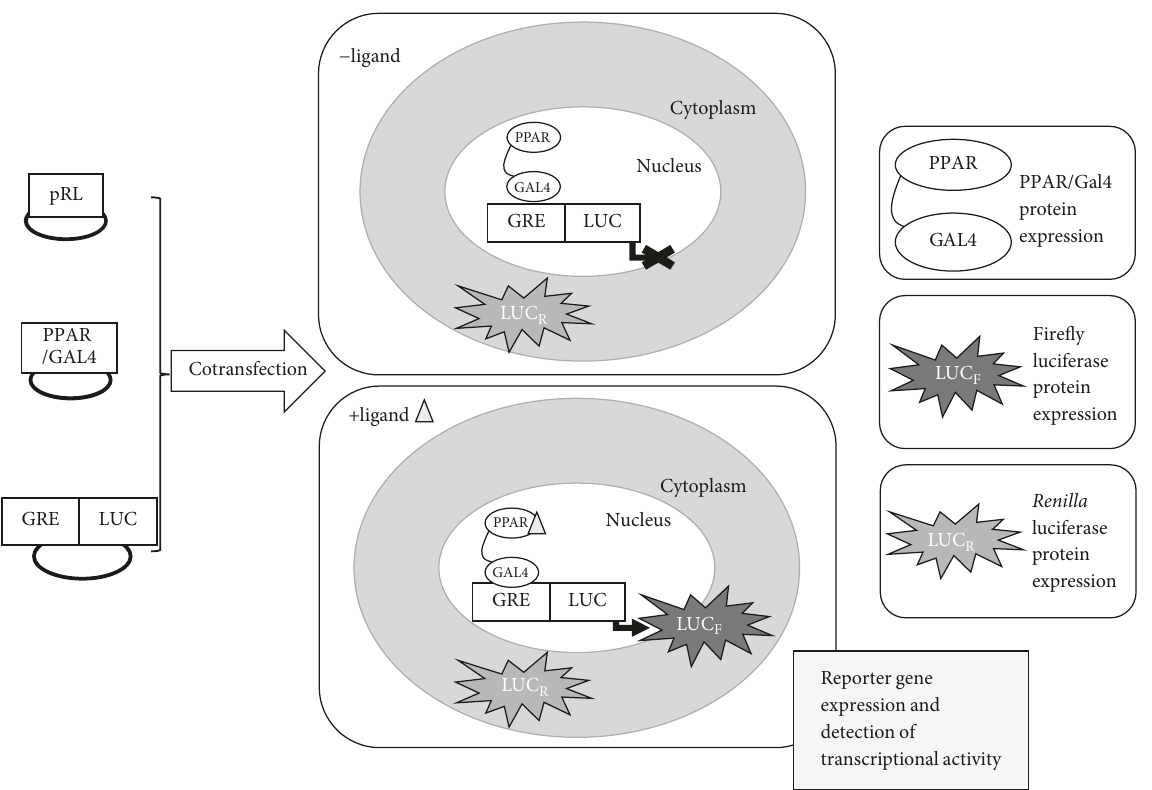
Figure1:Principleofthe invitro PPARß/ 𝛿 transactivationassay.Thisassayisbasedonthetransienttransfectionofthe293Tcelllinewiththree plasmids: pBIND-PPARß/ 𝛿 encoding a chimera of Gal4-DBD and PPARß/ 𝛿 -LBD genes (PPAR/GAL4); pGRE-LUC, which owns one GAL4 response element upstream of a firefly luciferase reporter gene (LUC F ); and the pRL vector, which constitutively express Renilla luciferase (LUC R ). The transfected cells express both PPARß/ 𝛿 and Renilla luciferase constitutively. When the transfected cell is exposed to a molecule that works as a ligand (+ligand), such as GW0742, PPARß/ 𝛿 moves into the nucleus, binds to GRE-LUC, and triggers the expression of LUC F , which is the expected PPARß/ 𝛿 activation effect in this assay. The reporter-gene expression correlates with the bioactivity of PPARß/ 𝛿 in the sample. Note. For simplicity, only PPARß/ 𝛿 monomer binding to GRE has been